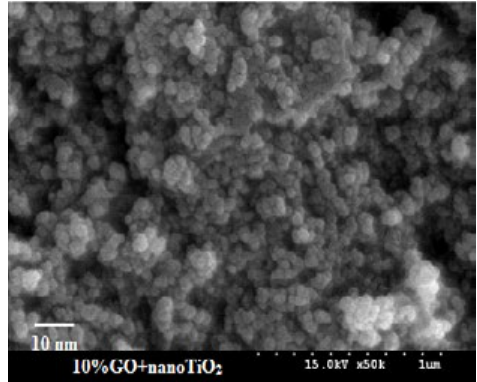
Fig.4 (a): FESEM image of 10 % GO-nanotitania composite Fig.4 (a) FESEM image of 10 % GO-nanotitania composite Fig.4 (a) FESEM image of 10 % GO-nanotitania composite